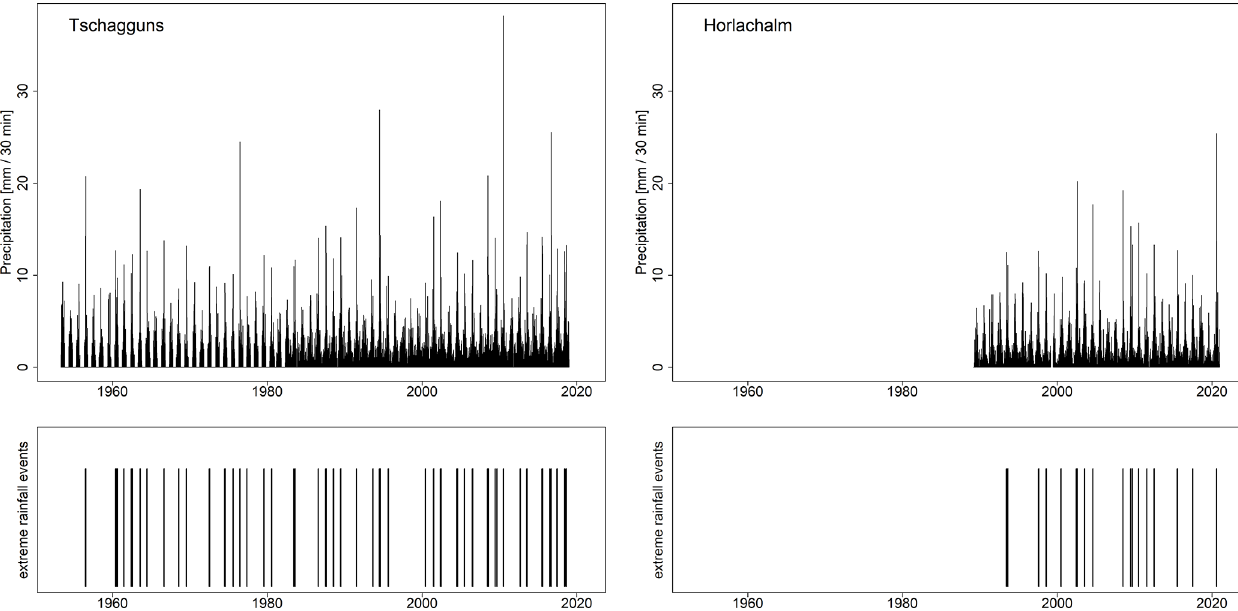
Figure 9. Recorded precipitation data of the meteorological stations Tschagguns and Horlachalm. Days with intensities exceeding 10mm per 30min are marked in the respective bottom plots.